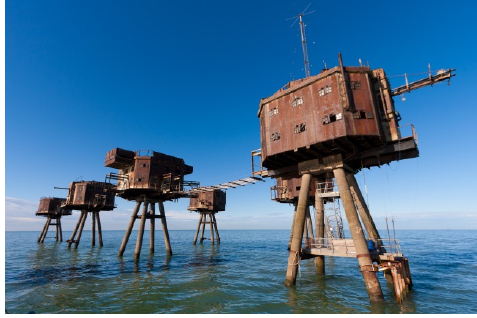
Figure 7. Maunsell Sea Fort. CC BY ‐ SA 3.0, Wikimedia Commons.